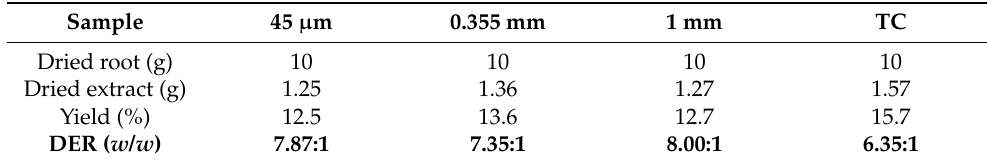
Table 5. Effect of D. villosa root powder particle size on the extract yield.